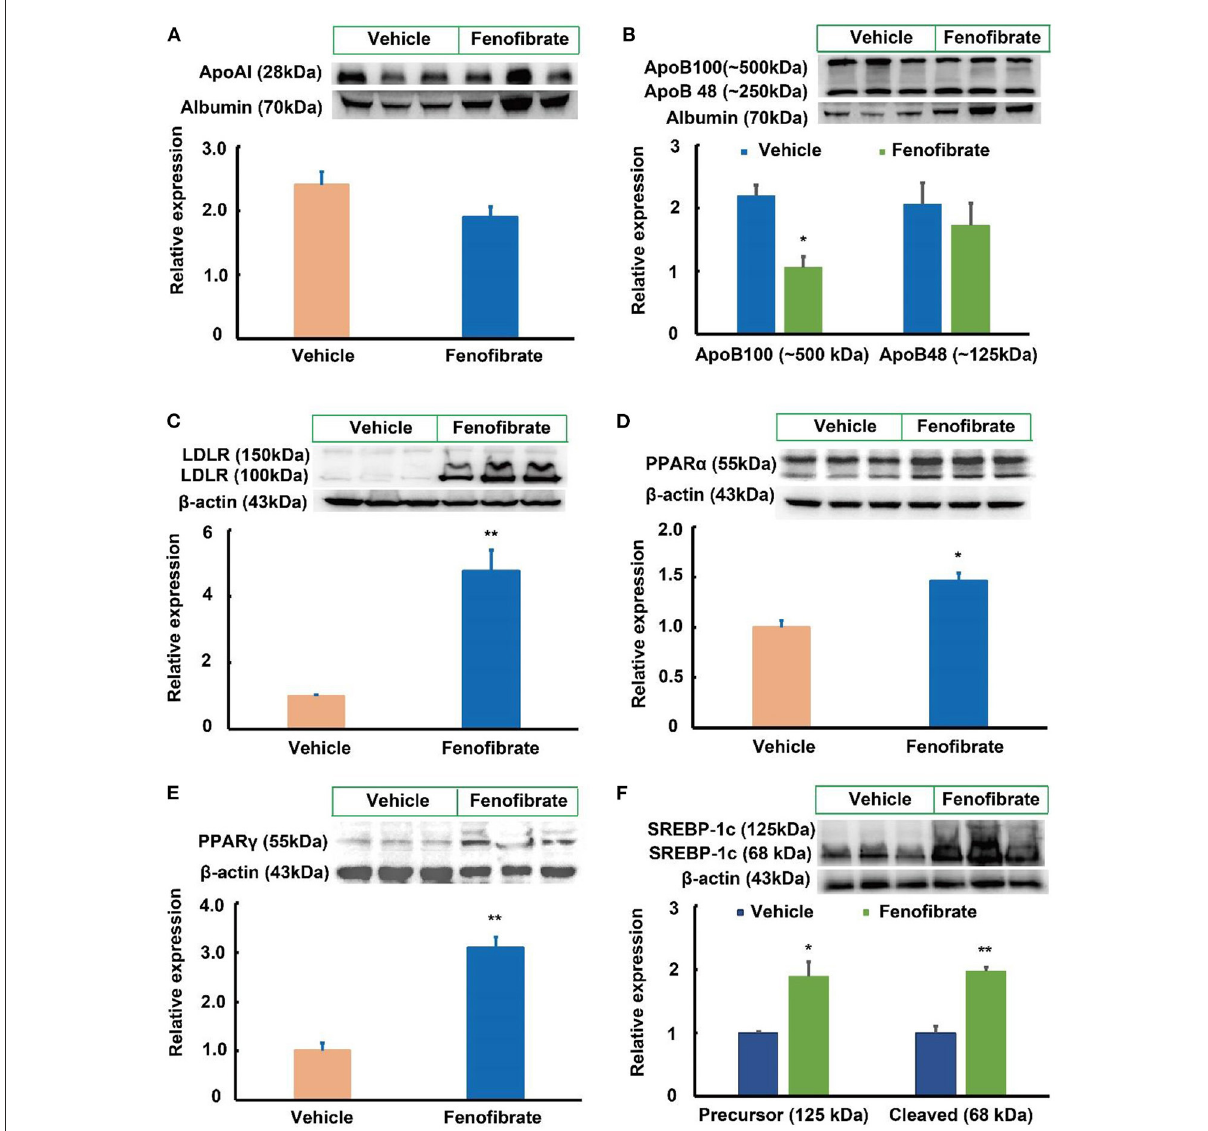
FIGURE3 Effect of fenofibrate on the expression of proteins involved in lipid metabolism in the plasma and liver of the ob/ob mice ( n = 6). (A) protein expression and densitometric quantification of plasma apolipoprotein (Apo) A-I; (B) protein expression and densitometric quantification of plasma Apo B; (C) protein expression and densitometric quantification of low-density lipoprotein receptor (LDLR) in the liver; (D) protein expression and densitometric quantification of peroxisome proliferator activated receptor (PPAR) α in the liver; (E) protein expression and densitometric quantification of PPAR γ in the liver; (F) protein expression and densitometric quantification of sterol regulatory element binding protein (SREBP)-1c in the liver. Data were expressed as mean ± SD, and the statistical analysis was performed by Student- t -test. * means significantly different at p < 0.05 vs. Vehicle group; ** means significantly different at p < 0.01 vs. Vehicle group. Vehicle: mice were treated with 0.5mL of water by gavage for 13 weeks; Fenofibrate: mice were treated with 0.5mL of fenofibrate suspension liquid at the dose of 20 mg/kg/d by gavage for 13